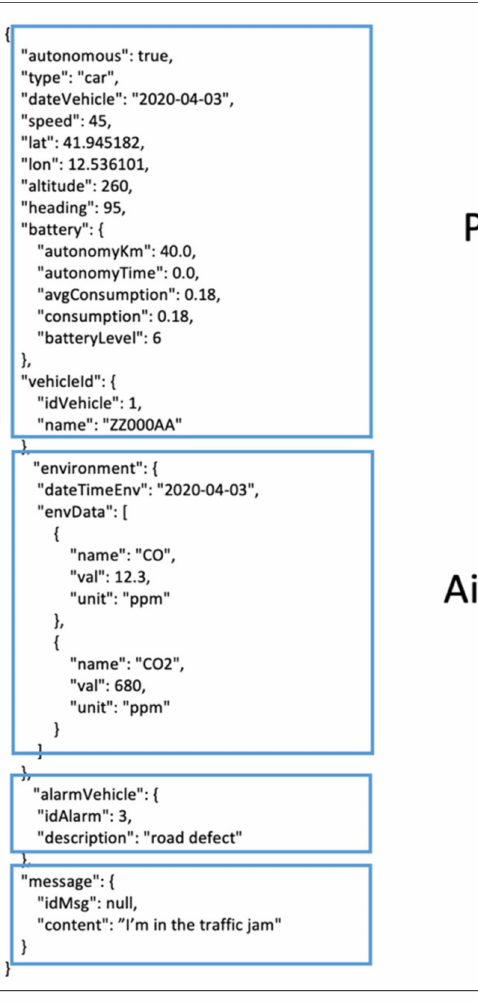
Figure A1. Example of a JSON message produced by the vehicle and acquired by